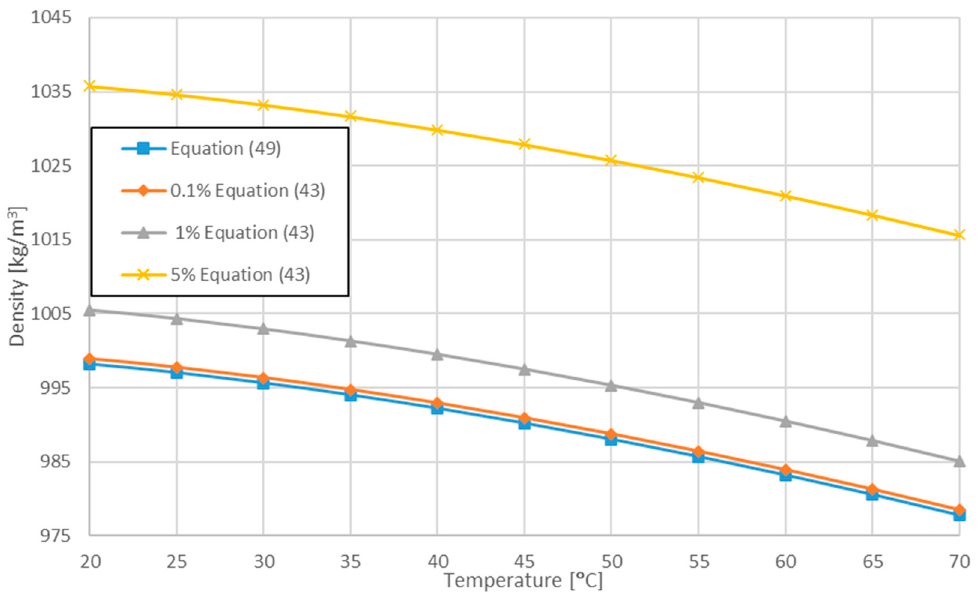
Figure 8. Density of water-Al 2 O 3 nanofluids.